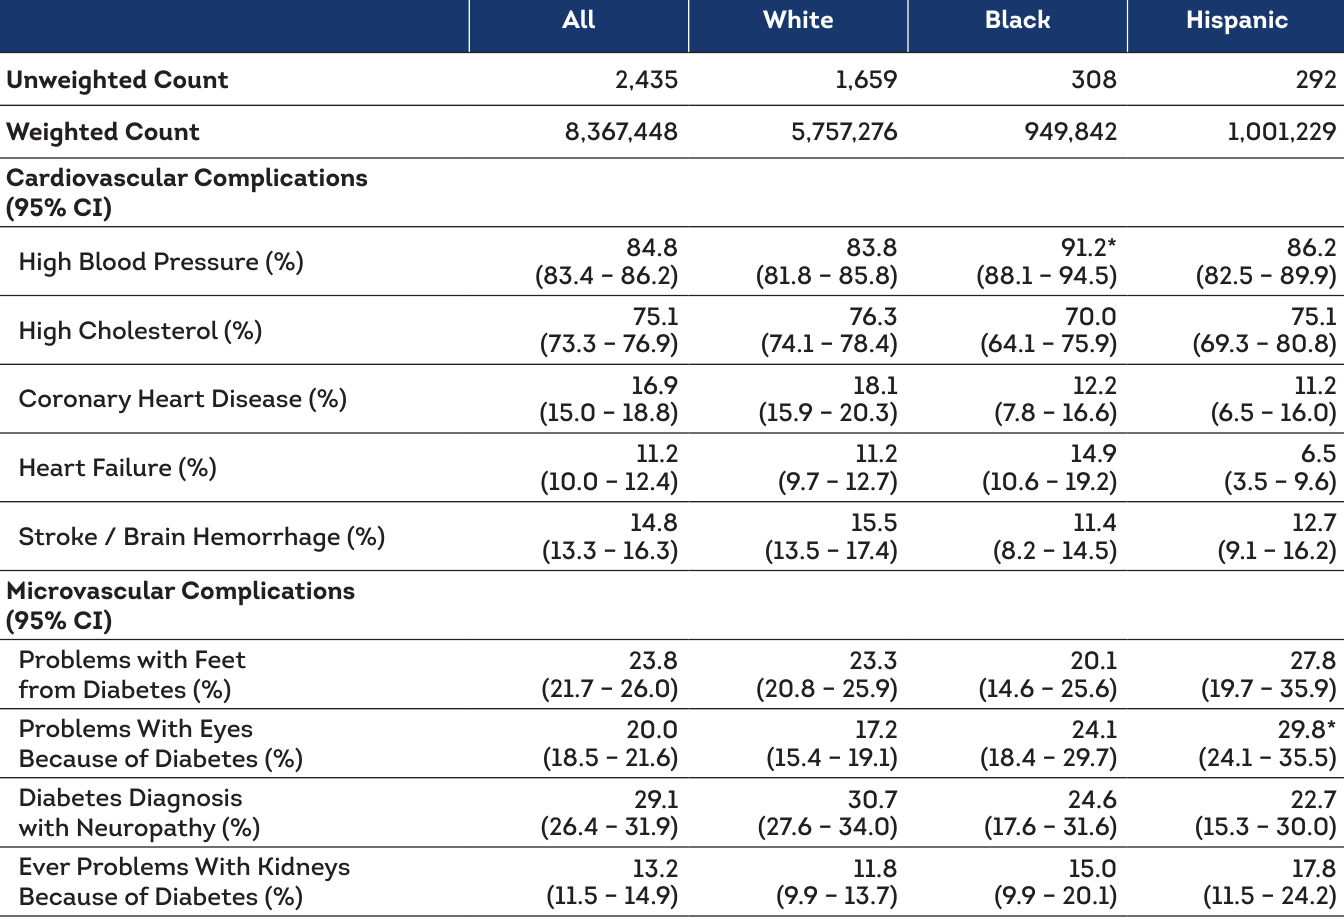
Table A6: Measures of diabetic complications, among community-dwelling Medicare beneficiaries diagnosed with diabetes, by race/ethnicity All White Black